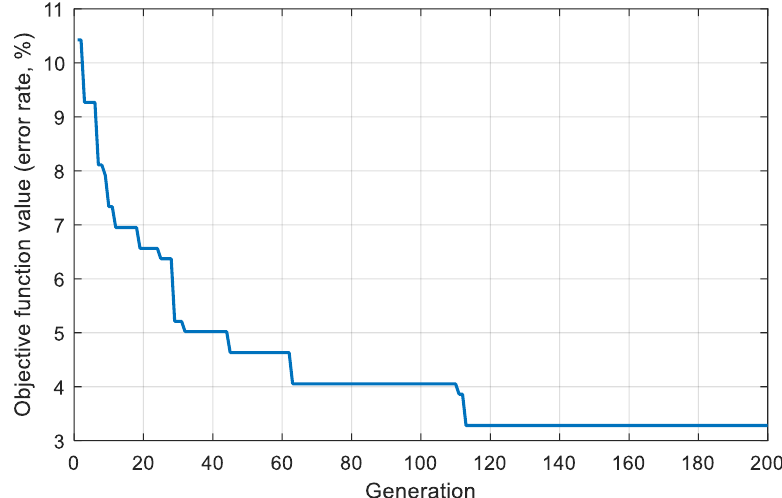
Figure 7. The evolution curve of GA-ELM classifier.